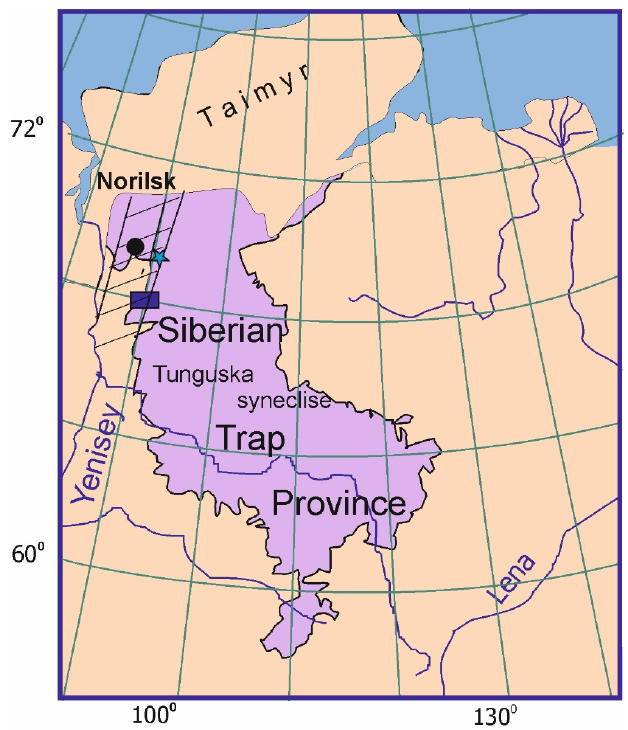
Figure 1. Map of the Siberian flood basalt province with the position of the Kulyumber area (dark rectangle). The shaded area is the Norilsk–Igarka paleorift zone, the star shows position of the volcanic Section 2 in the Lake Lama area. Black dot is Norilsk city.